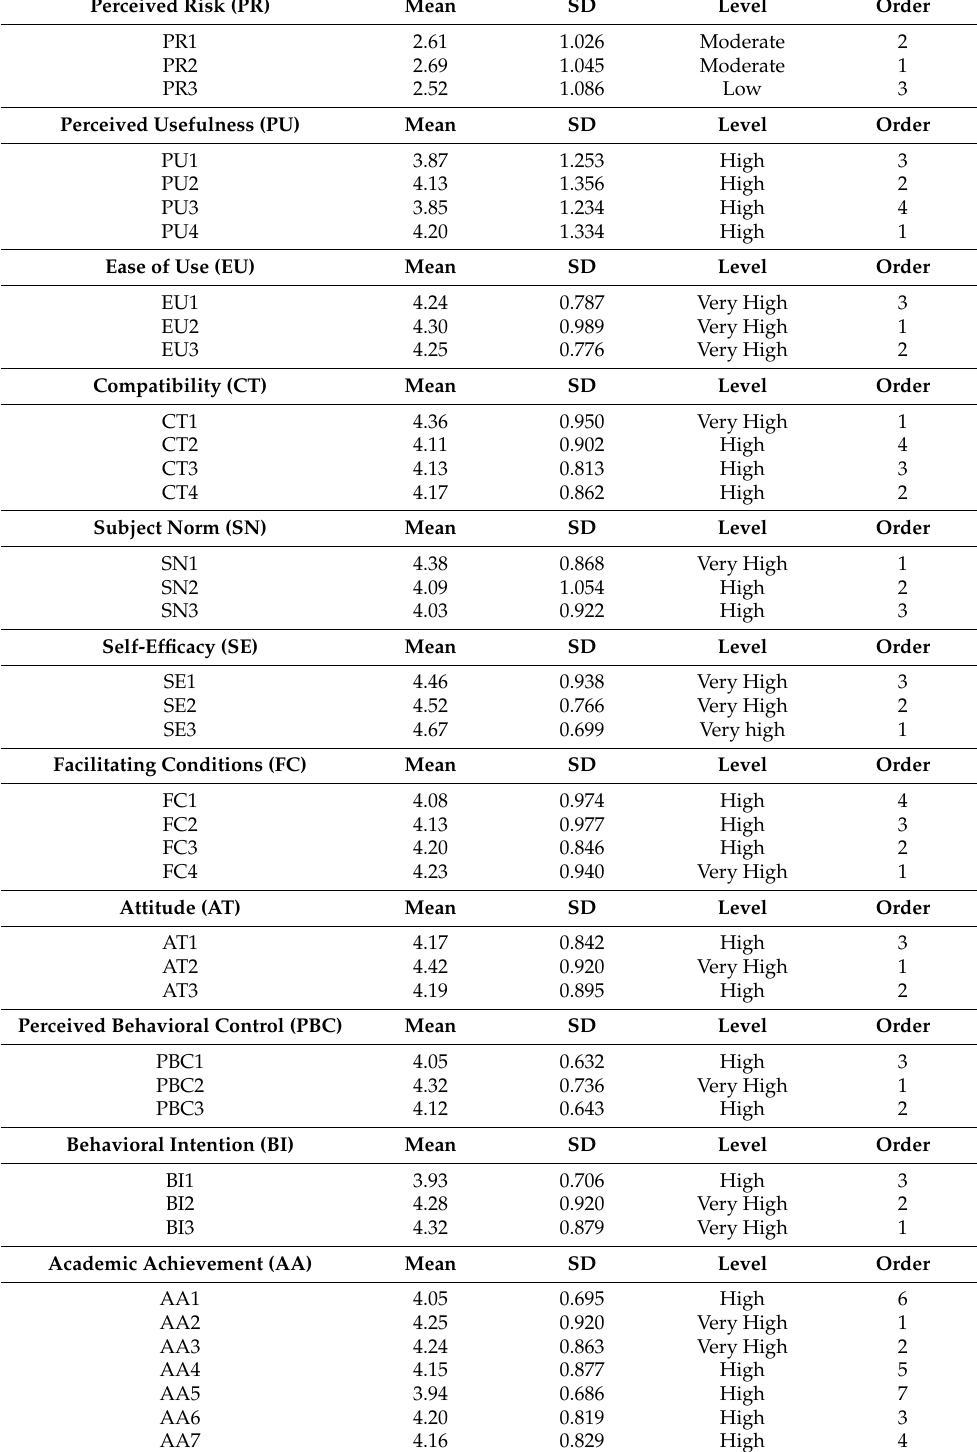
Table 4. Mean and standard deviation of the study’s